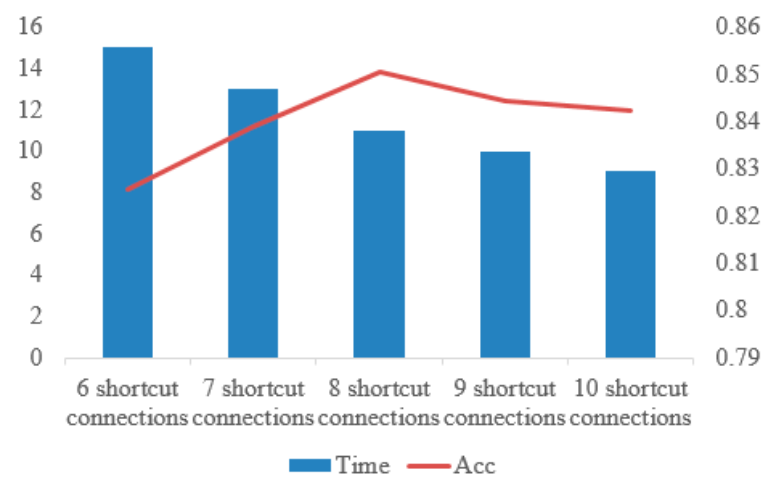
Figure 16. Comparison of time and accuracy under different numbers of shortcut connections.